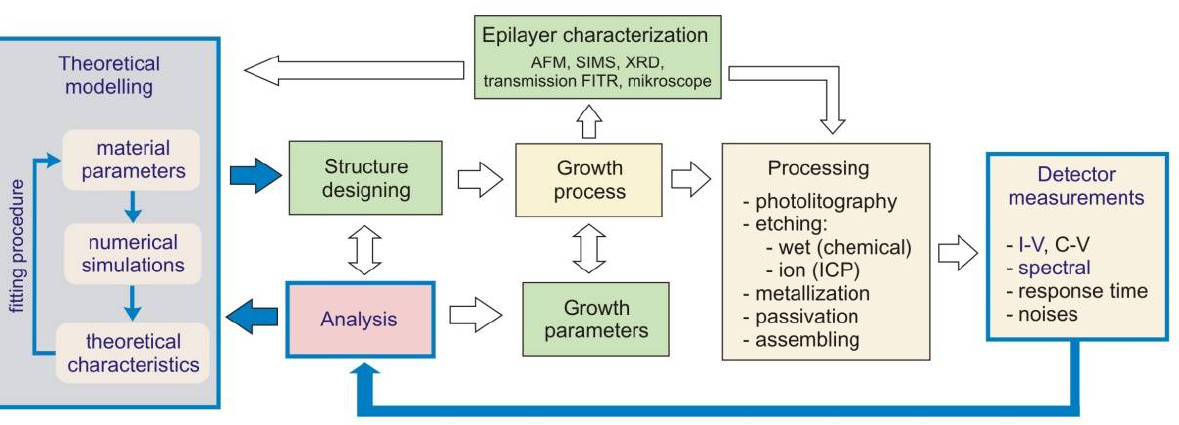
Figure 2. Typical procedure algorithm illustrating the characteristic steps in detector design, con- struction, and characterisation.